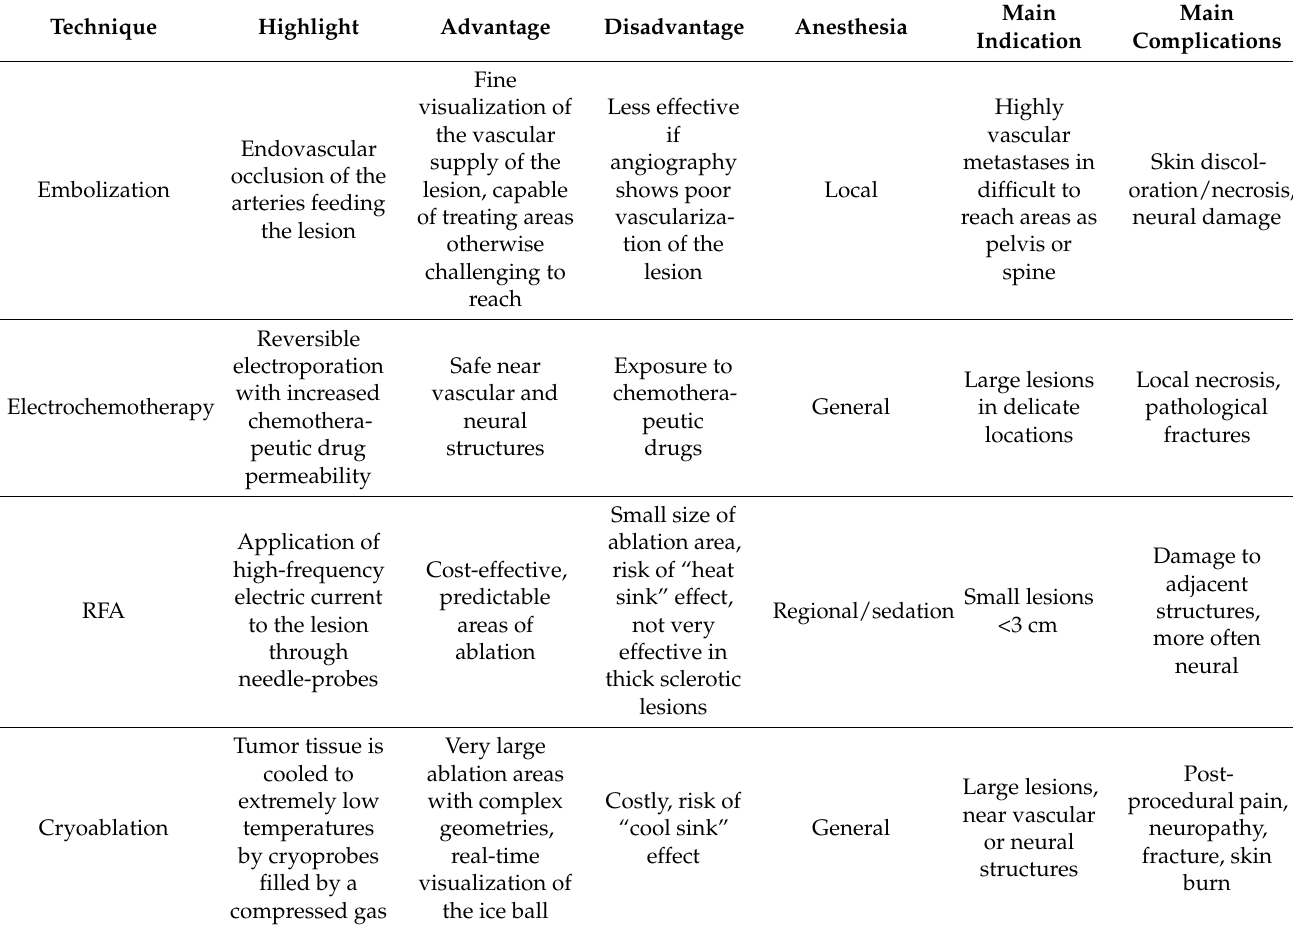
Table 3. Features of the minimally invasive interventional procedures